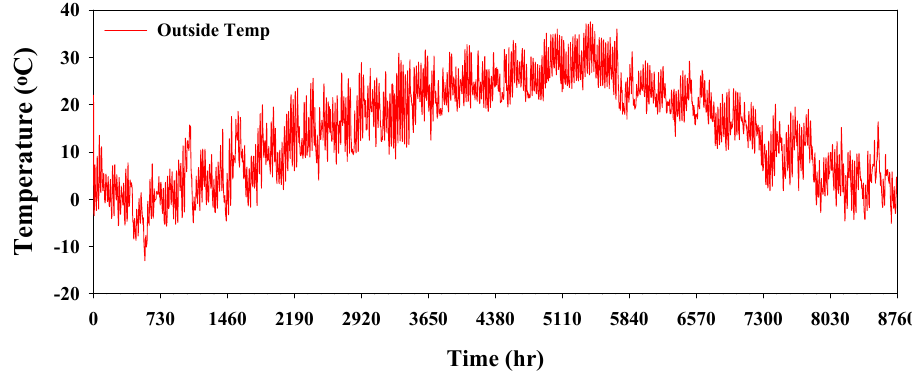
Figure 3. Hourly mean temperature outside the greenhouse.